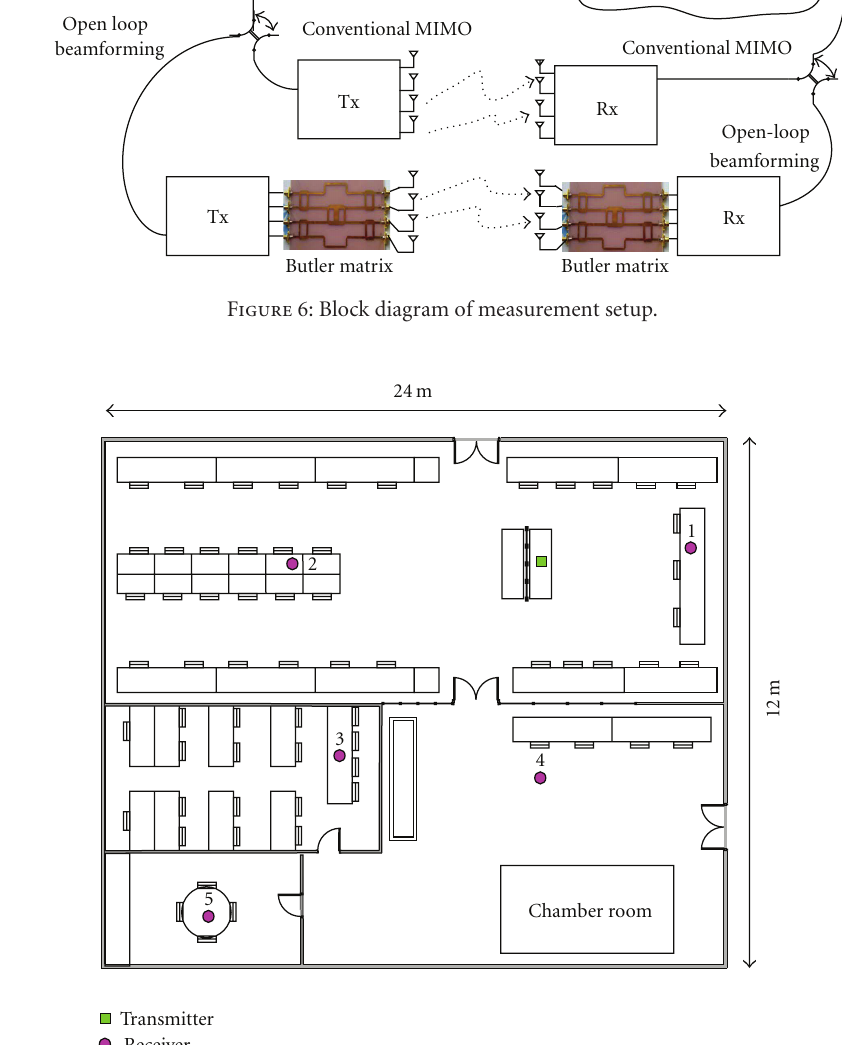
Figure 7: Measurement